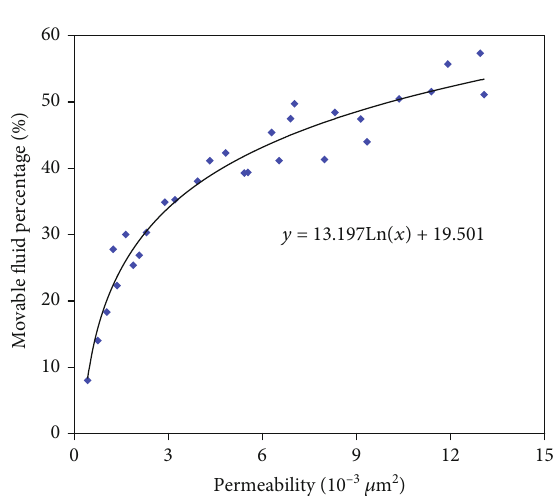
Figure 6: Relationship between movable fl uid percentage and